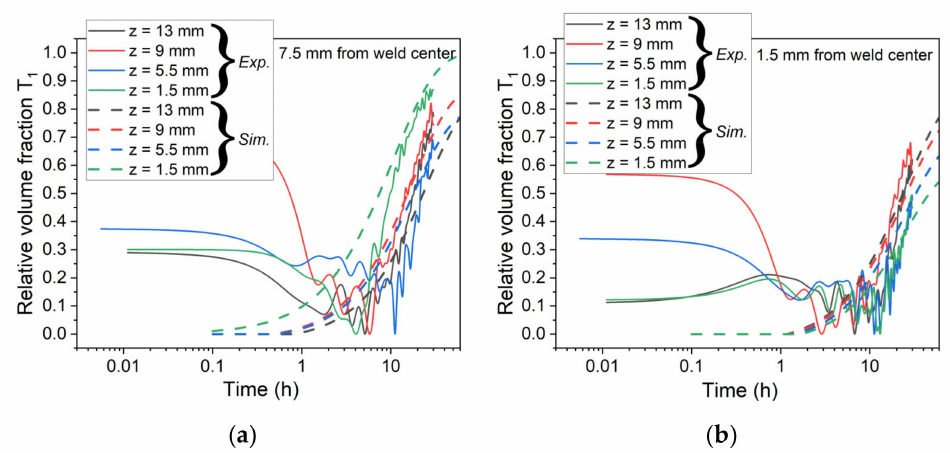
Figure 17. The experimental (electrical resistivity measurements) and simulated evolutions of relative volume fraction of the T 1 phase during post-weld heat treatment at 155 ◦ C at ( a ) 7.5 mm; and ( b ) 1.5 mm from the weld center. The revised model is used for the simulations. At 7.5 mm from the weld center, the bottom of the weld joint may be considered as the T34 state, whereas the middle and top of the weld joint belong to the nugget which led to a lower volume fraction of the T 1 phase at the end of the heat treatment. At 1.5 mm, the four heights are in the weld nugget which led also to a lower normalized volume fraction, especially at the bottom of the